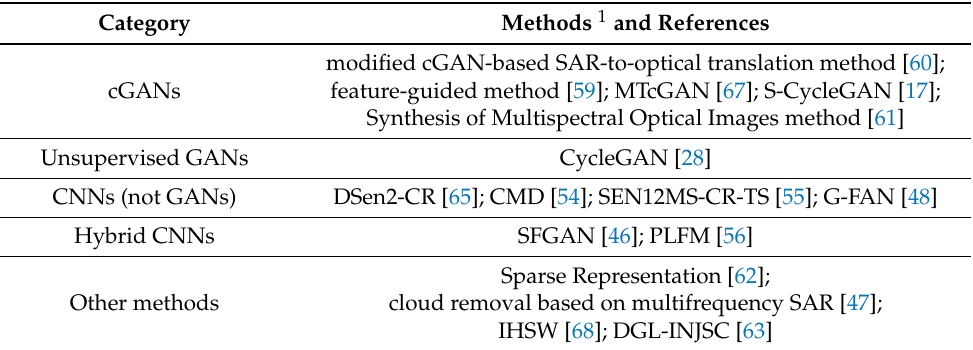
Table 2. Categories of the existing cloud removal methods of optical remote sensing imagery using SAR. ( 1 Names of these methods were extracted from the literature. If the methods were not named in the literature, the words describing the methods’ major characteristics were used to name them here. cGANs: conditional generative adversarial networks. CNNs: convolutional neural networks.)